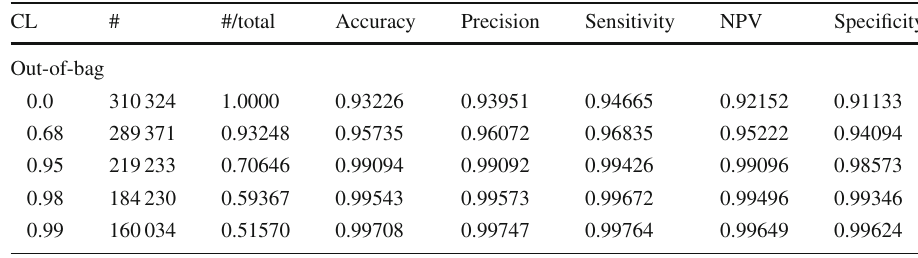
Table 10 Results of the validation of the RF classifier with a split dataset (0.75 training, 0.25 testing)